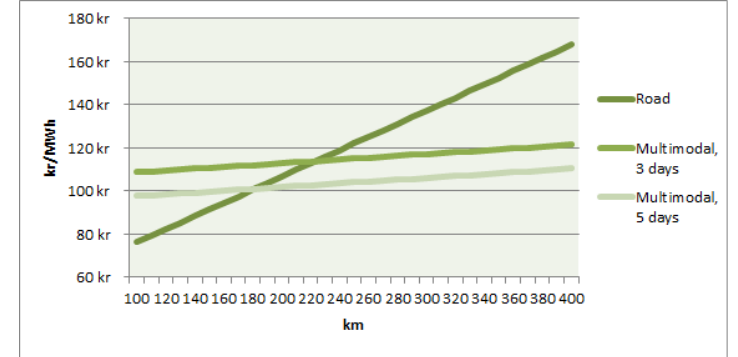
Figure 3. Costs for the biofuel